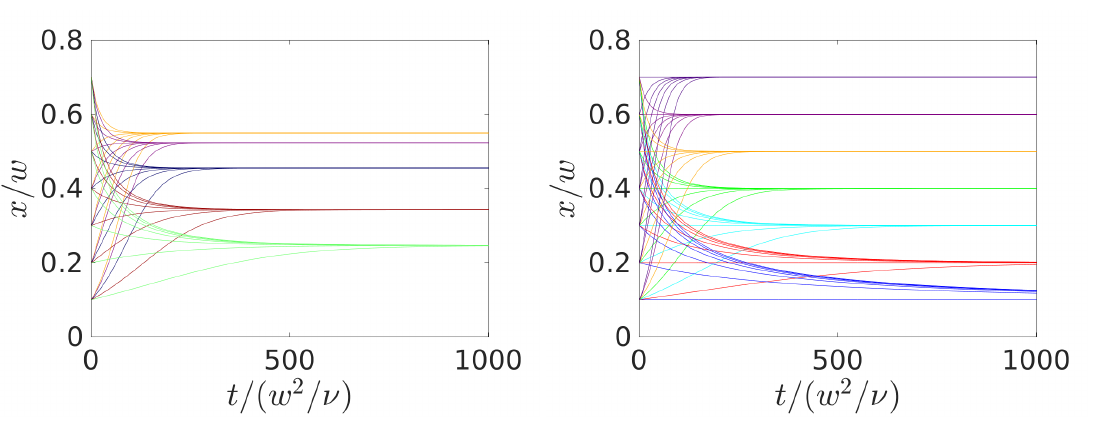
Figure 4. Inertial focusing of a colloid with radius a = 0.2 w starting from different initial positions and using constant control forces. Lateral position versus time is plotted. ( Left ): for constant control forces f ctl / ( ρν 2 ) = 1.5, 1.0,0,1.0,1.5 (which give an increasing equilibrium x position or stable − − fixed point). ( Right ): for adjusted constant control forces such that the stable fixed point assumes the values x / w =